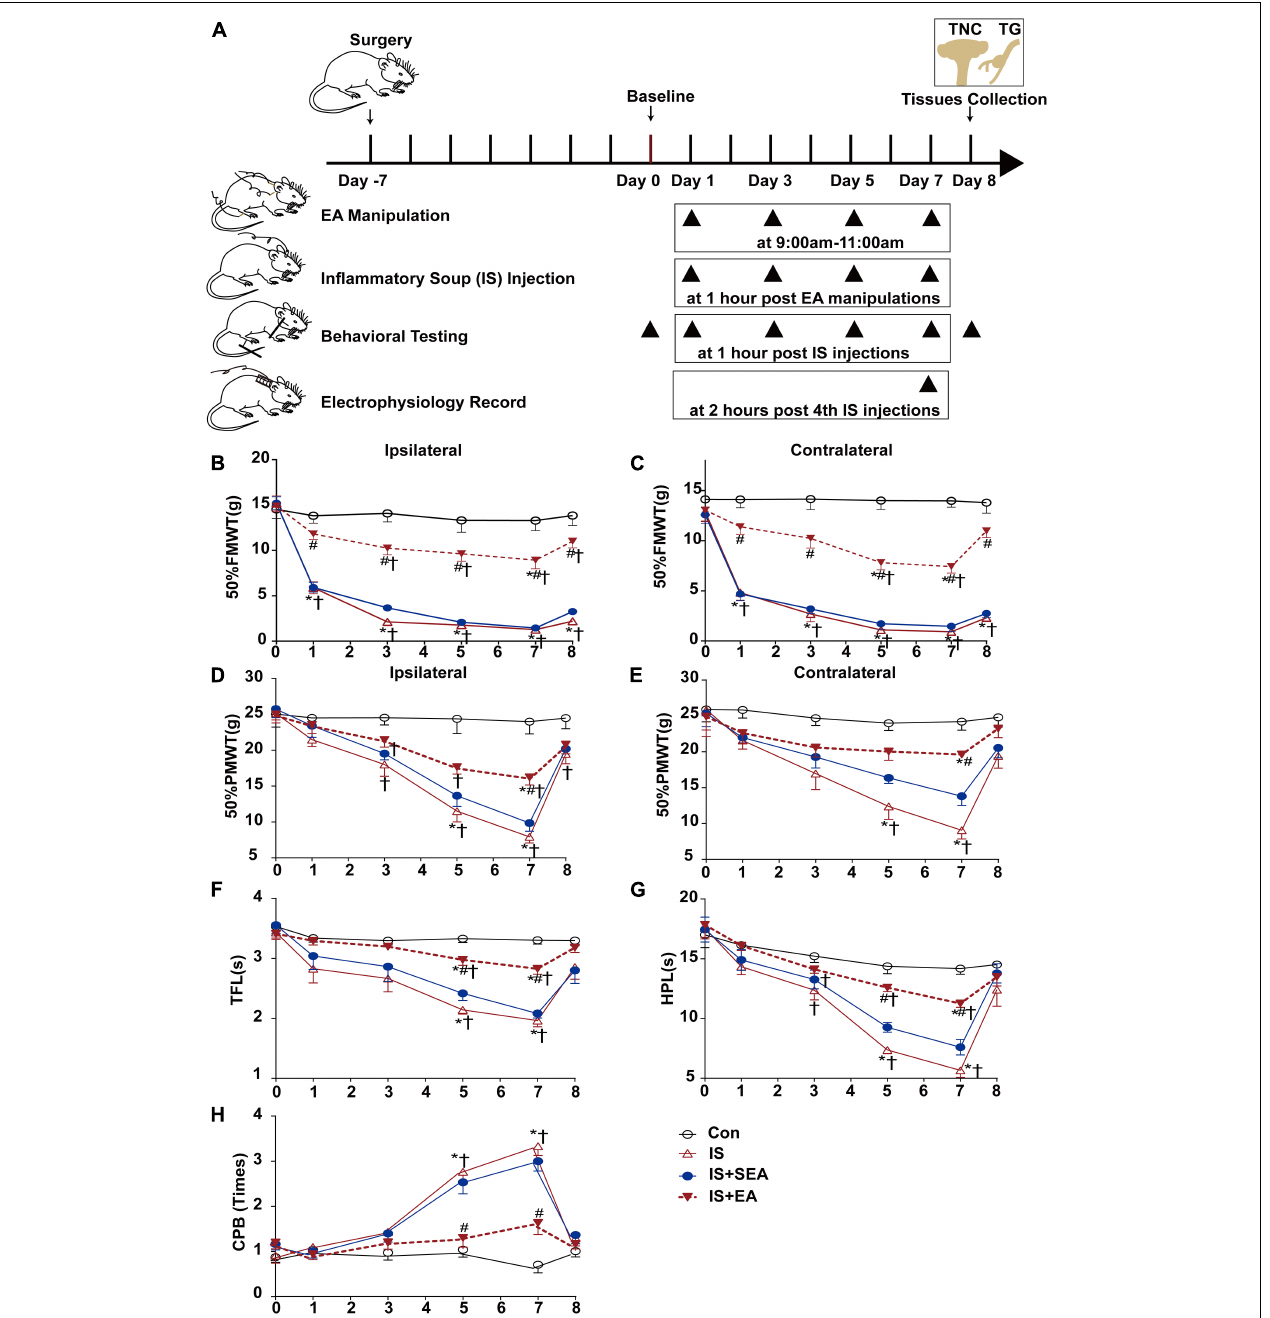
FIGURE 1 | Effects of EA on IS-induced mechanical and thermal hyperalgesia. (A) Scheme of the experimental design. Rats were applied EA manipulation, following repeated-dural IS injection on days 1, 3, 5, and 7, then measurements of 50%FMWT, 50%PMWT, TFL, HPL, and CPB to examine the extent of mechanical and thermal hyperalgesia after 1 h of IS injection and also the day 0 without IS injection and 1 day after the 4th IS injection (day 8). (B,C) Reduction in 50%FMWT of IS + EA and IS compared with the Con group ( n = 10; * P < 0.05); increase in 50%FMWT of IS + EA compared with the IS group on the bilateral side ( n = 10; # P < 0.05). (D,E) Effects of EA on extracephalic mechanical hyperalgesia after dural IS injection. There was an increase of the 50%PMWT in the IS + EA group compared with the IS group on the bilateral side ( n = 10, # P < 0.05). The TFL (F) , and HPL (G) decrease and CPB (H) increase in the IS group compared with the Con group ( n = 10, * P < 0.05) on days 5 and 7, there was an increase of the TFL and HPL and a decrease of CPB in the IS + EA compared with the IS group ( n = 10, # P < 0.05). The repeated-measure two-way ANOVA post hoc Tukey multiple comparisons test was used. Group values are indicated by mean ± SEM. * P < 0.05 compared with the Con group; # P < 0.05 compared with the IS group at the same time point; † P < 0.05 compared with the baseline on day 0; 50%FMWT, 50% facial mechanical withdrawal threshold; 50%PMWT, 50% paw mechanical withdrawal threshold; TFL, tail-flick latency; HPL, hot-plate latency; CPB, cold-plate behaviors; EA, electroacupuncture; IS, inflammatory soup; SEA, sham electroacupuncture; Con,